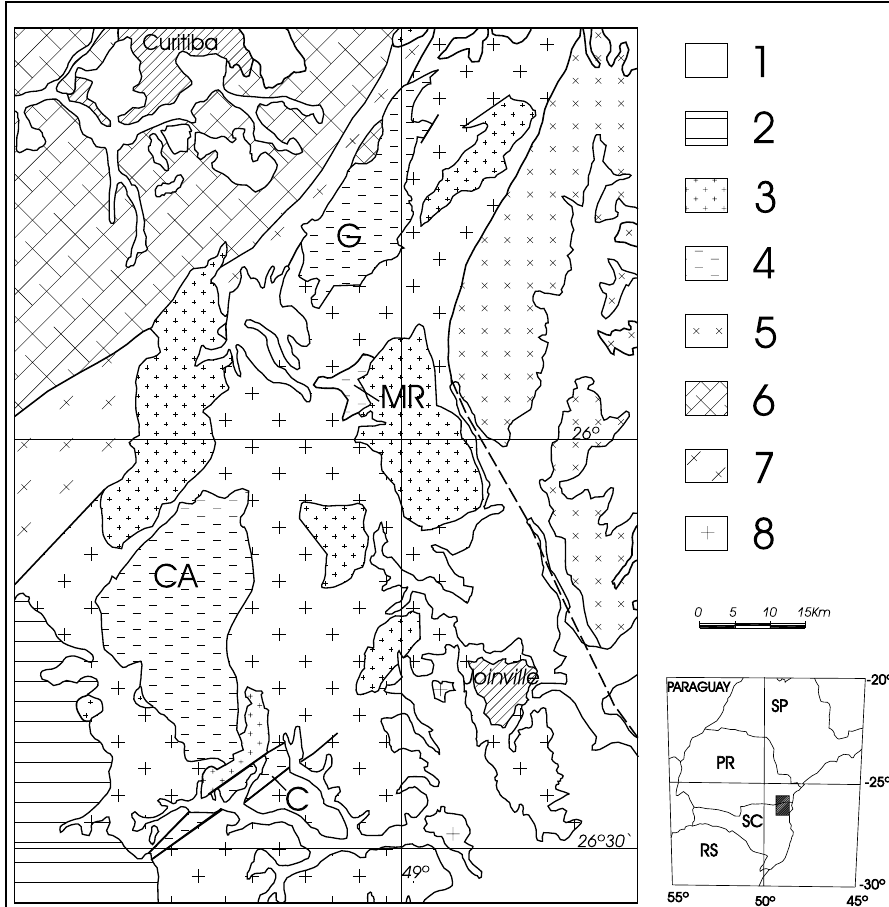
Fig. 1 – Simplified geological map showing the Campo Alegre (CA) and Guaratubinha (G) basins, the Corupá (C) sub-basin, and the volcanic rocks (MR) associated with the Morro Redondo Massif. Both basins are located within the Luis Alves domain, close to its northern border. 1) Quaternary alluvium; 2) Phanerozoic Paraná Basin; 3) Neoproterozoic Anorogenic Granitoid; 4) Fini-Proterozoic volcano-sedimentary basin; 5) Paraná Batholith (Neoproterozoic calc-alkaline granitoid); 6) Curitiba Domain (Paleoproterozoic to Neoproterozoic banded gneiss); 7) Piên Batholith (Neoproterozoic arc-related deformed granitoid); 8) Luis Alves Microplate (Paleo- proterozoic high-grade